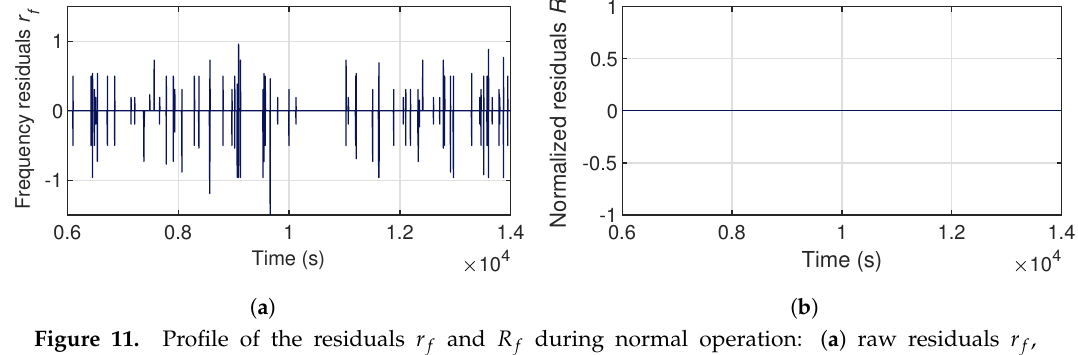
Figure 11. Profile of the residuals r f and R f during normal operation: ( a ) raw residuals r f , ( b ) normalized residuals R f .